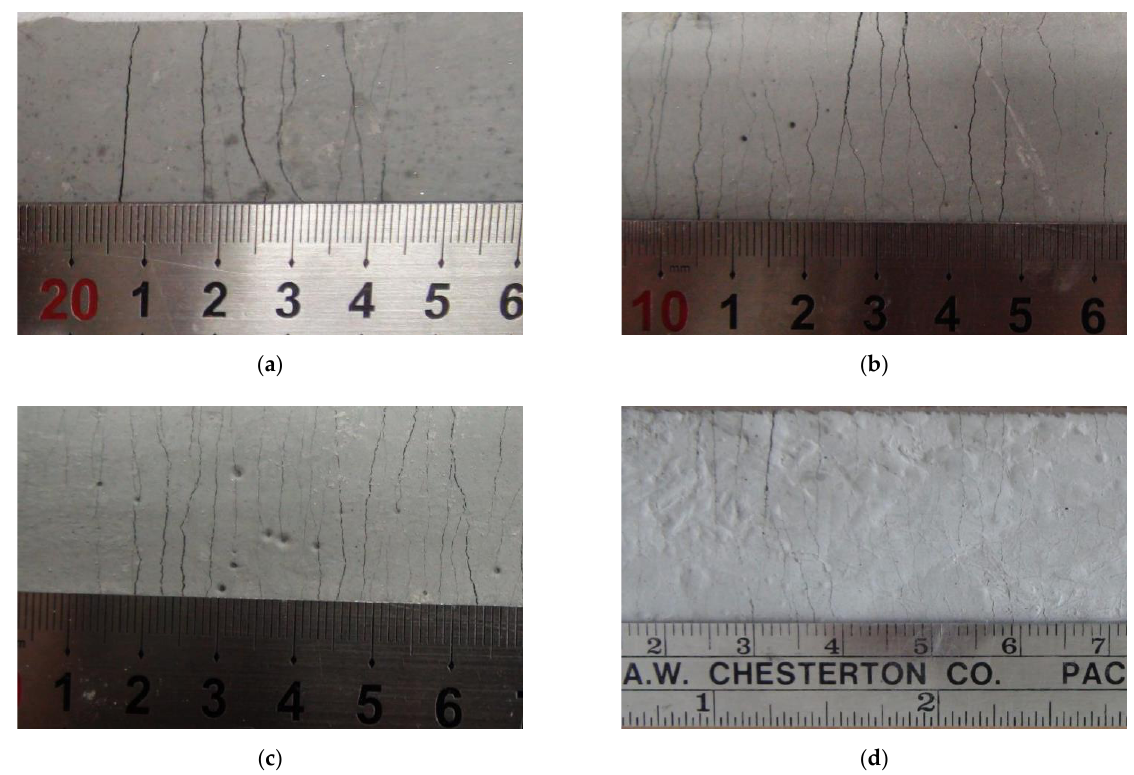
Figure 7. Multiple microcracks of tensile specimens: ( a ) ASFC100 (PVA 1.00 vol.%); ( b ) ASFC125 (PVA 1.25 vol.%); ( c ) ASFC150 (PVA 1.50 vol.%); ( d ) ASFC200 (PVA 2.00 vol.%).